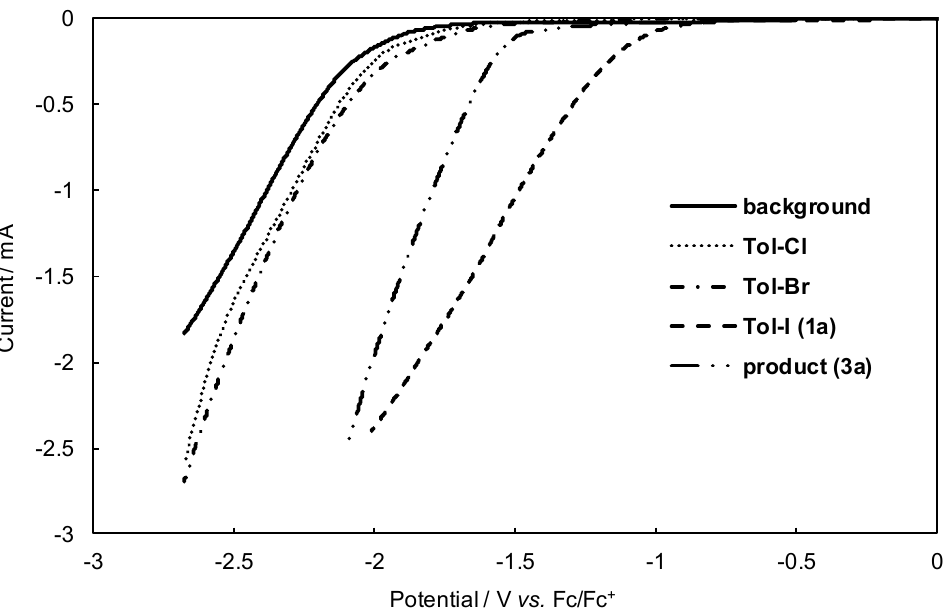
Figure 2. Linear sweep voltammograms of 4-chlorotoluene ( Tol-Cl ), 4-bromotoluene ( Tol-Br ), 4-iodotoluene ( 1a ), and the cross-coupling product ( 3a ) in N,N -dimethylformamide (DMF) electrolytic solution at a scan rate of 0.1 V·s − 1 .